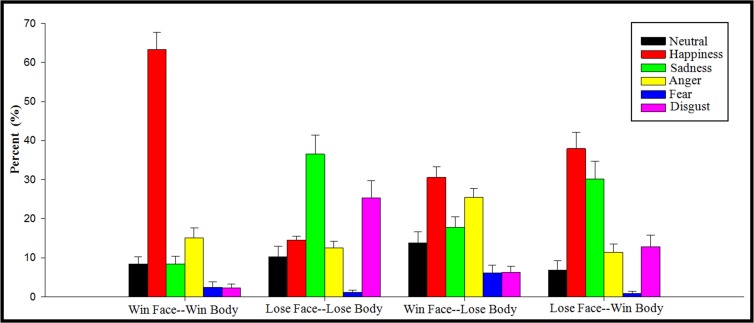
Rating for the type of emotion expressed by faces in different face-body conditions.